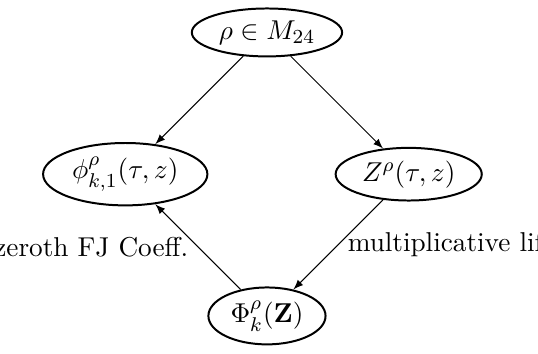
Figure 1 . Moonshine for M 24 . φ ρ Z ρ ( τ, z ) is the twined elliptic genus. Φ ρ